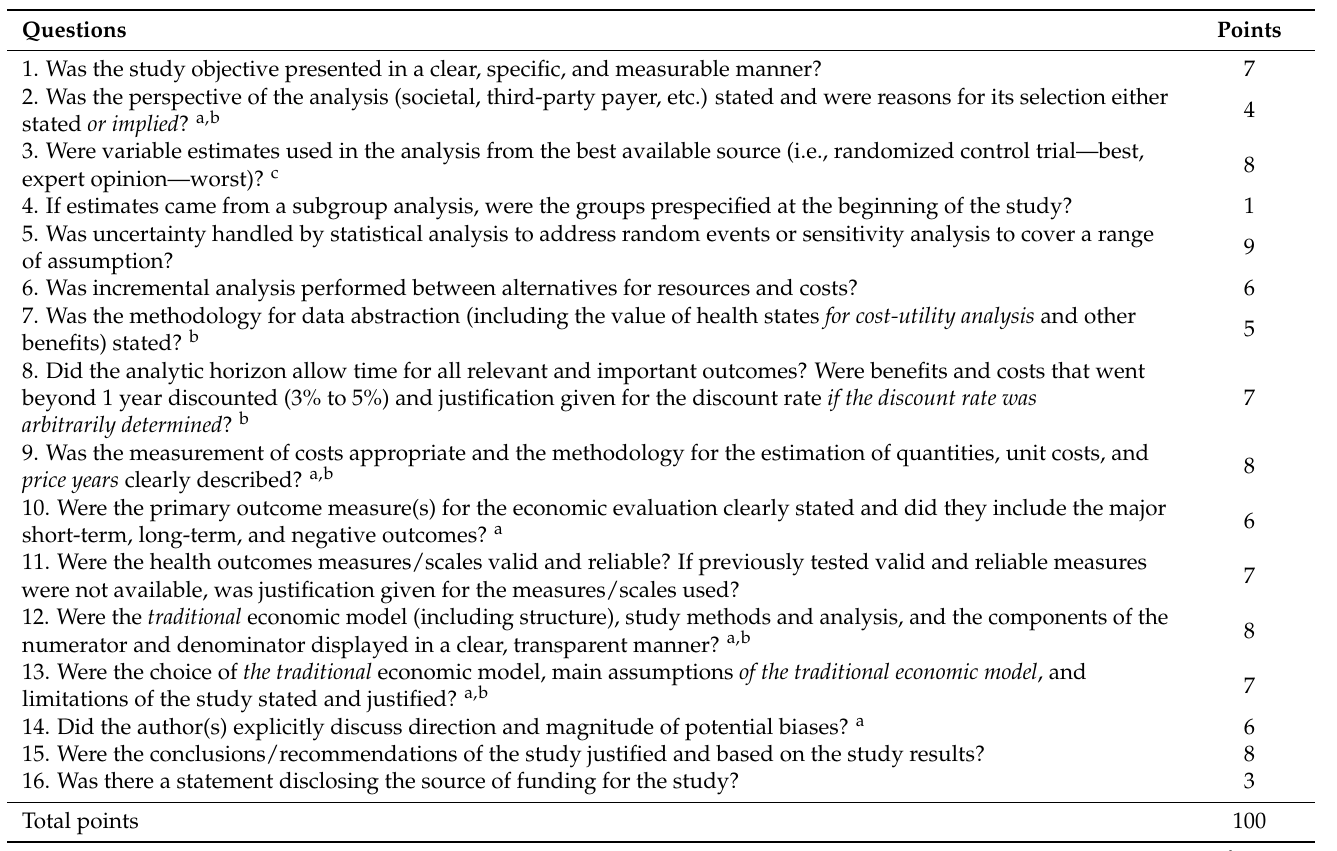
Table 1. The Quality of Health Economics Studies (QHES)